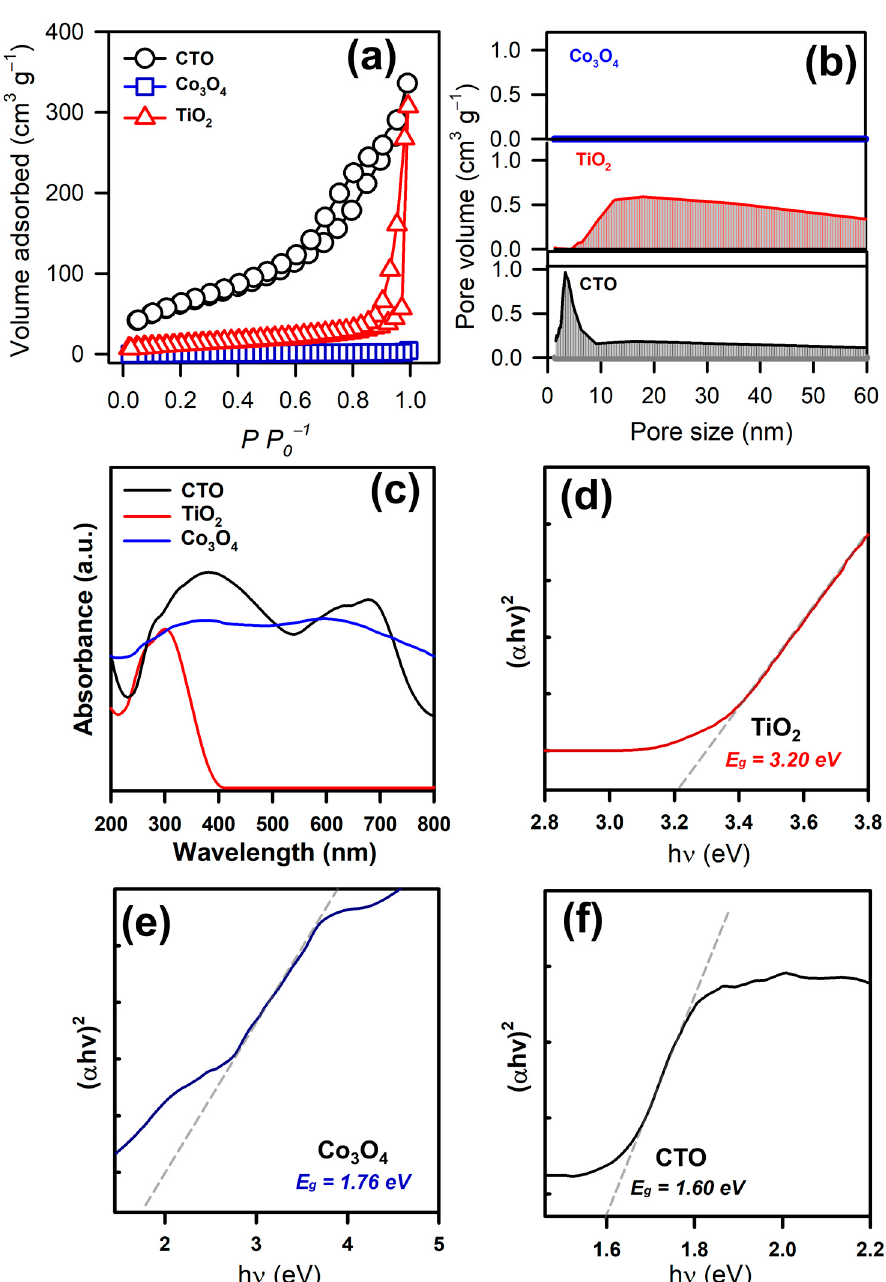
Figure 3. ( a ) N sorption isotherms, ( b ) pore size distributions, ( c ) DRS, and ( d – f ) Tauc plots of CTO, 2 TiO , and Co O . TiO 2 , and Co 3 O 4 2 3 4